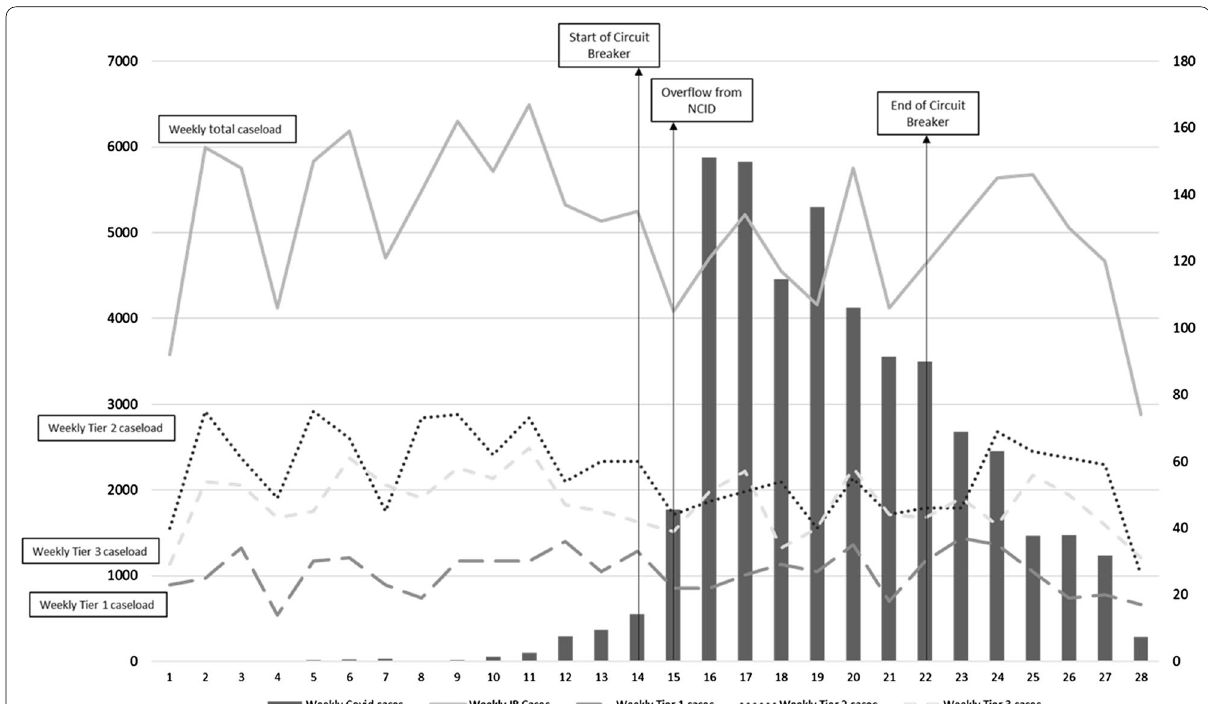
Fig. 2 Weekly number of COVID-19 cases with weekly IR procedures performed classified based on IR-PAS classification: graphs describing the weekly number of COVID-19 patients in Singapore (with labels demarcating key events), and the weekly number of IR procedures performed across all IR-PAS tiers